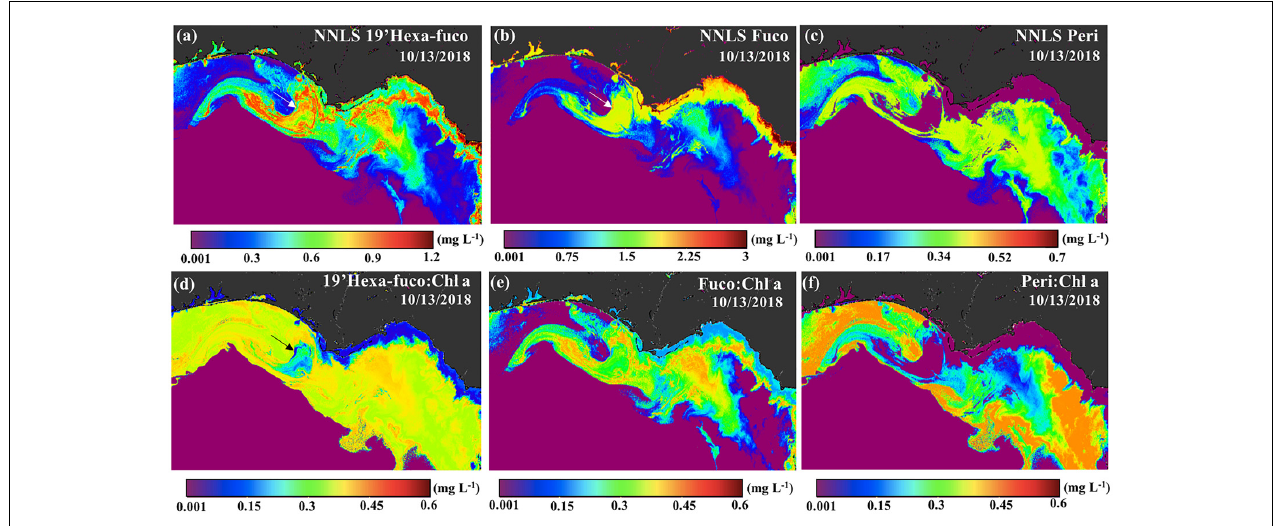
FIGURE 12 | Sentinel-3A OLCI-derived maps of diagnostic pigments and ratios for October 13, 2018. Pigment maps of (a) 19 (cid:48) hexa-fuco, (b) fuco, (c) peri, (d) 19 (cid:48) hexa-fuco:Chl a , (e) fuco:Chl a , (f) peri:Chl a